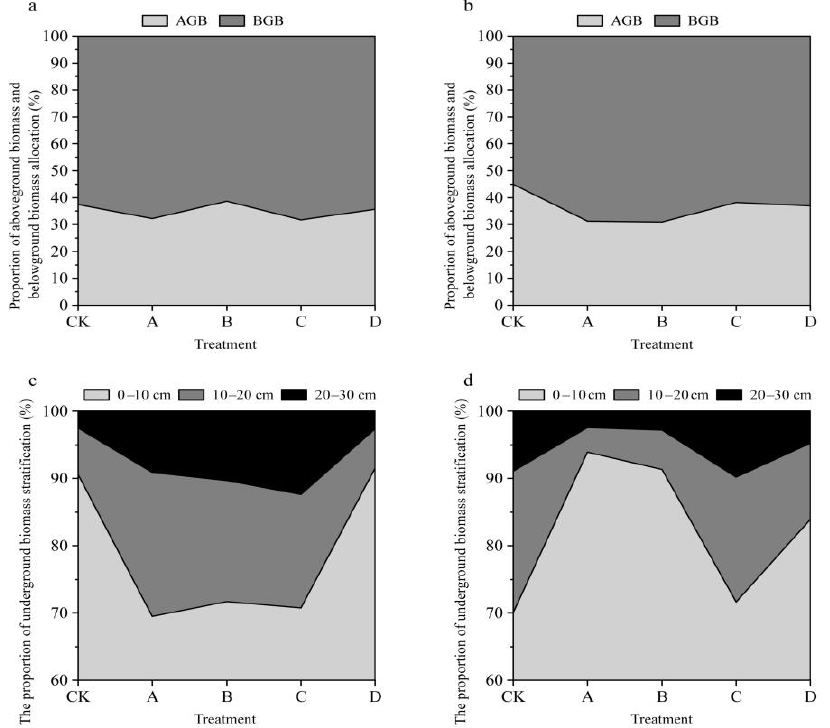
Figure 5. Effect of gradient warming and grazing on biomass distribution. ( a ), changes in the proportion of above-ground biomass and below-ground biomass allocated with the warming gradient when not grazed; ( b ), changes in the proportion of above-ground biomass and below-ground biomass allocated with the warming gradient when grazed; ( c ), changes in the proportion of below-ground biomass stratified with the warming gradient when not grazed; ( d ), changes in the proportion of below-ground biomass stratified with the warming gradient when grazed. The horizontal axis indicates the experimental treatments that resulted in different warming gradients.